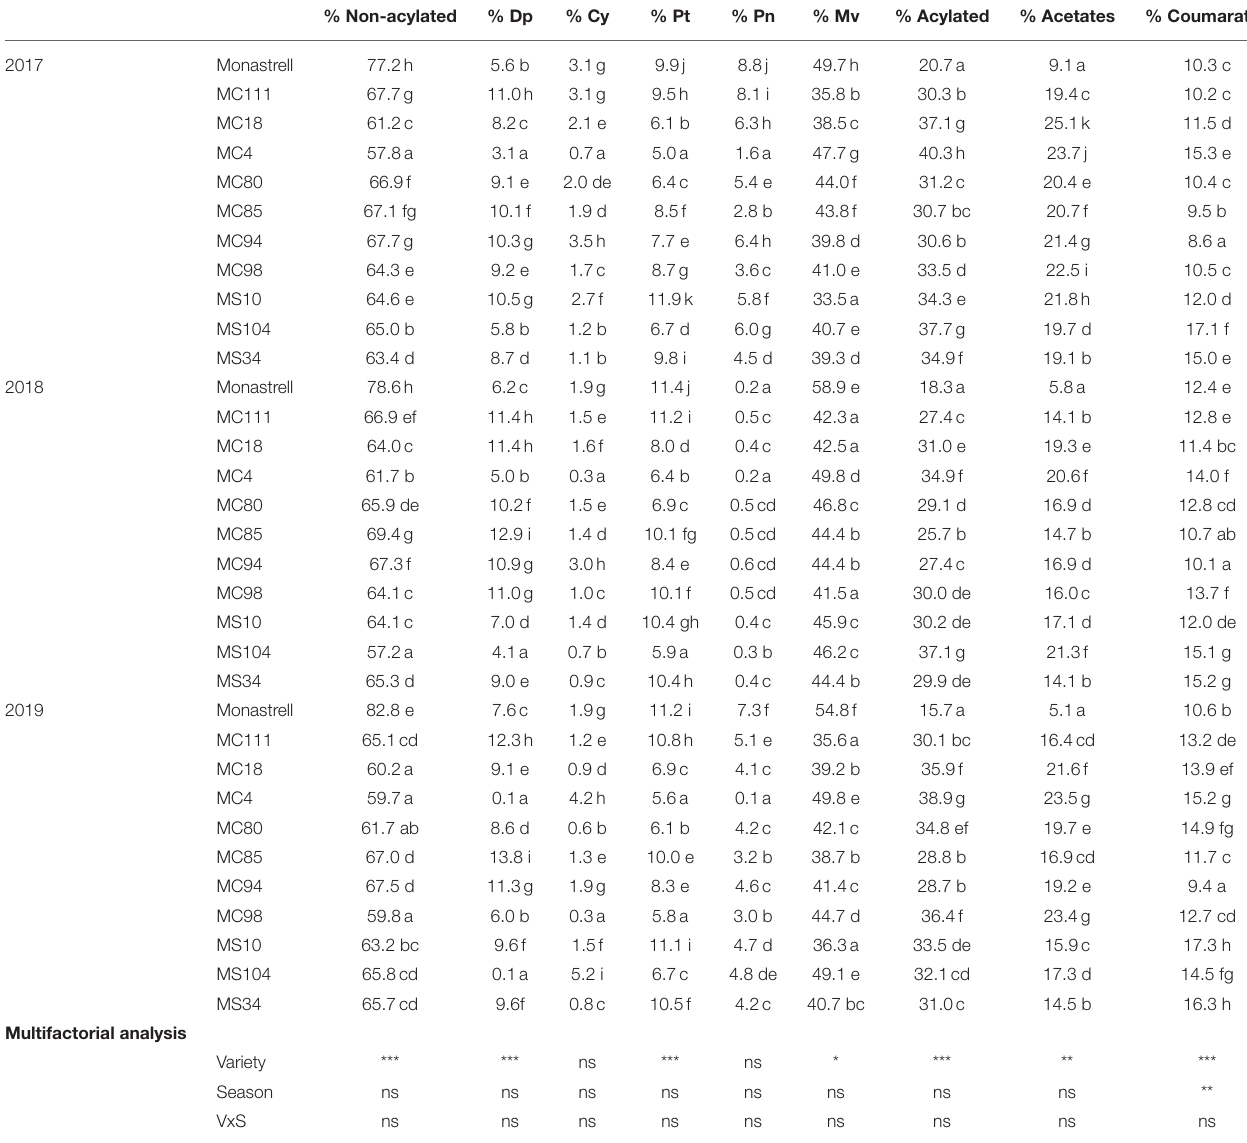
TABLE 4 | Profile of anthocyanins in Monastrell wines and their hybrids in the three seasons (2017–2019). % Non-acylated % Dp % Cy % Pt %